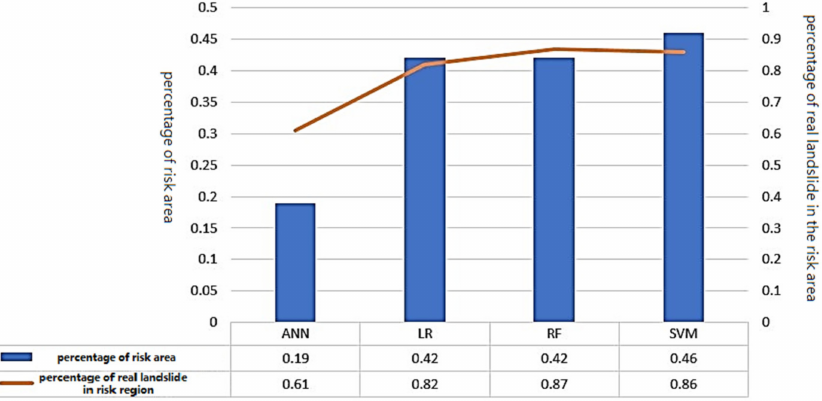
Figure 6. The statistical results of risk